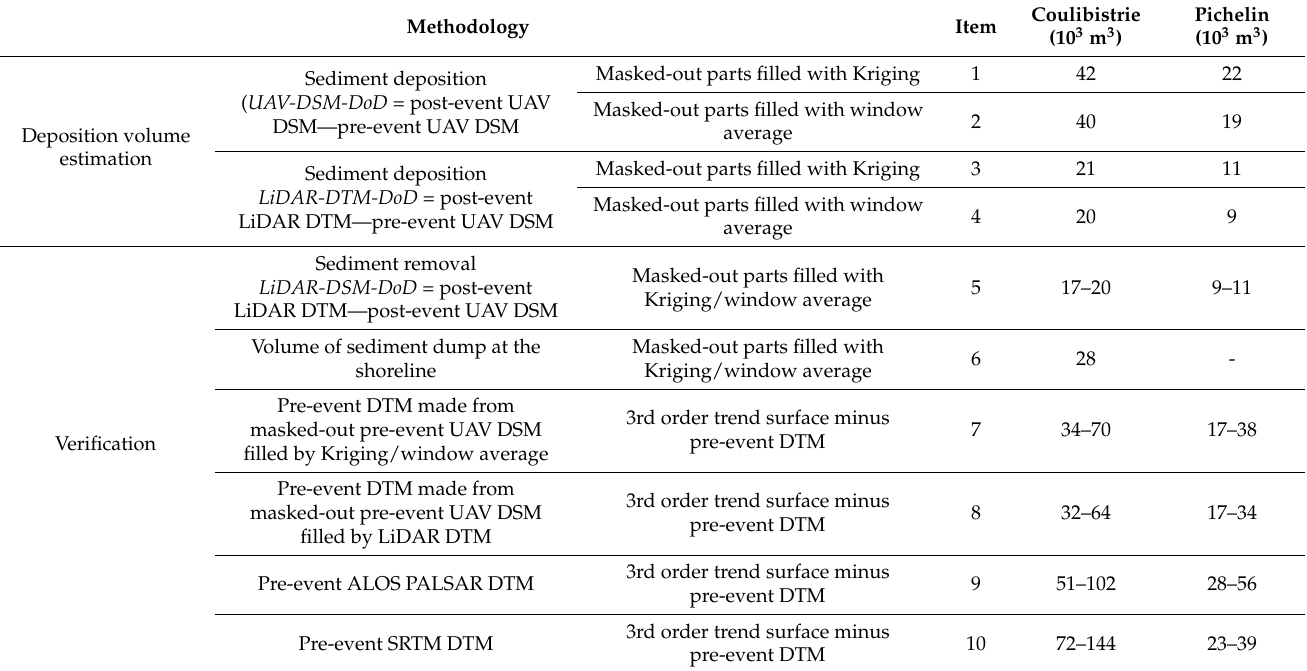
Table 3. Sediment volume estimations (all values are in 10 3 m 3 ). The sediment removal volumes and deposition volumes from trend analysis are stated as intervals.